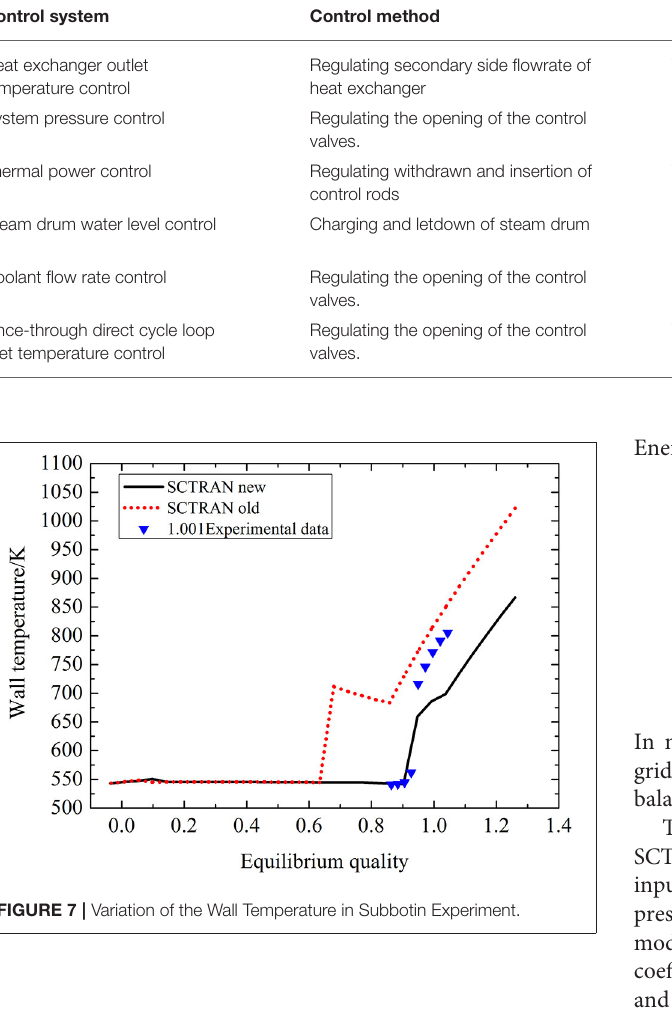
TABLE 5 | The disturbance conditions of control system.